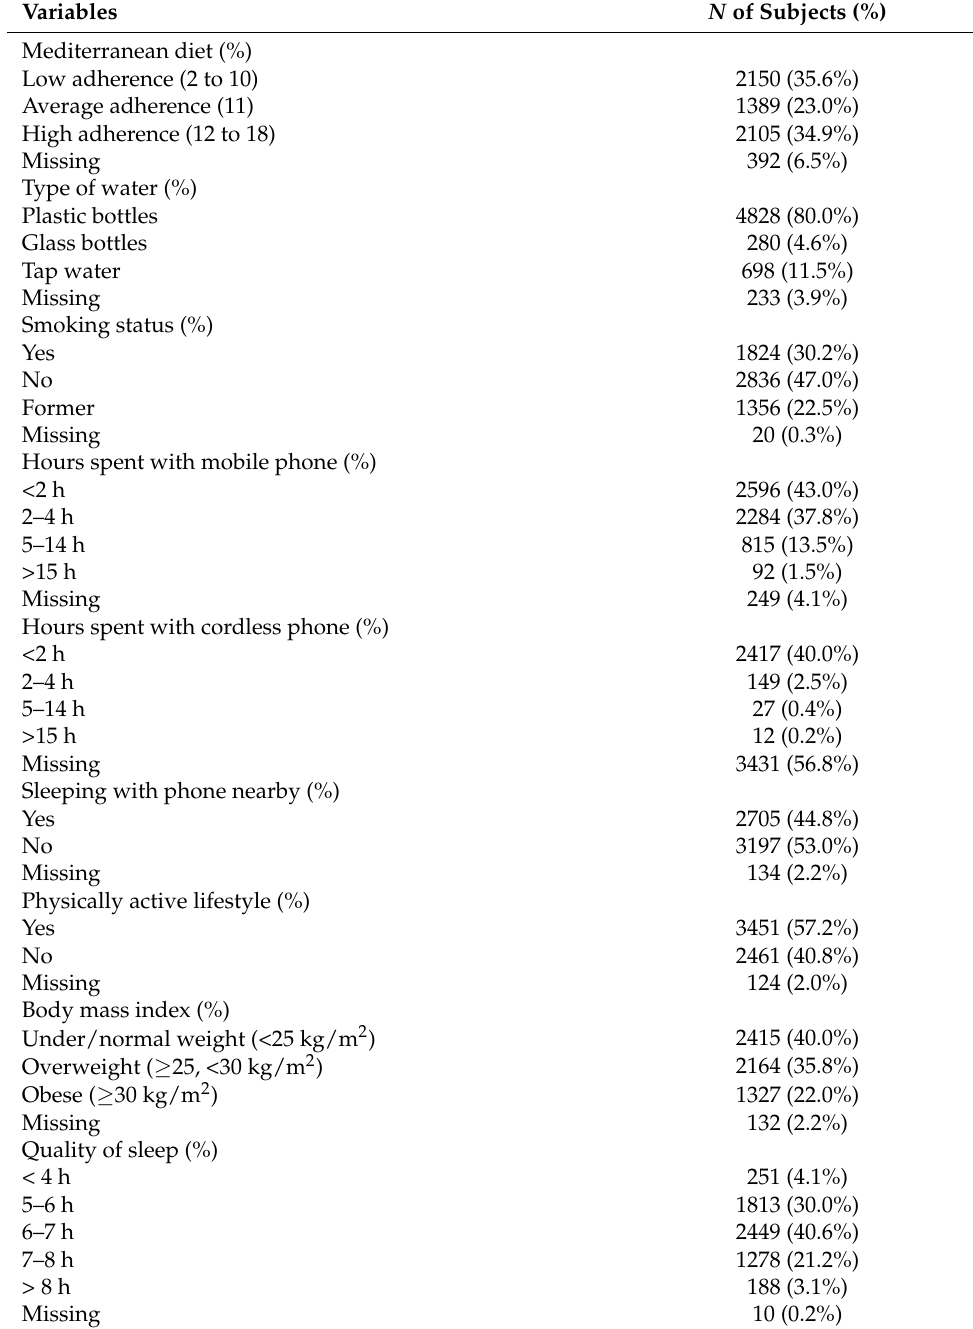
Table 2. Characteristics of the analysed cohort: lifestyles and proxy